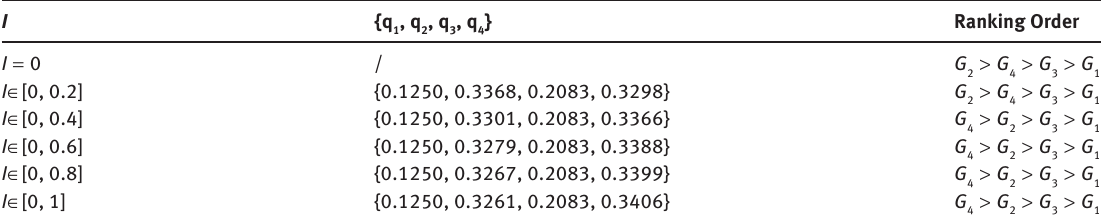
Table 1: Decision Results Selecting Different Indeterminate Ranges for I .